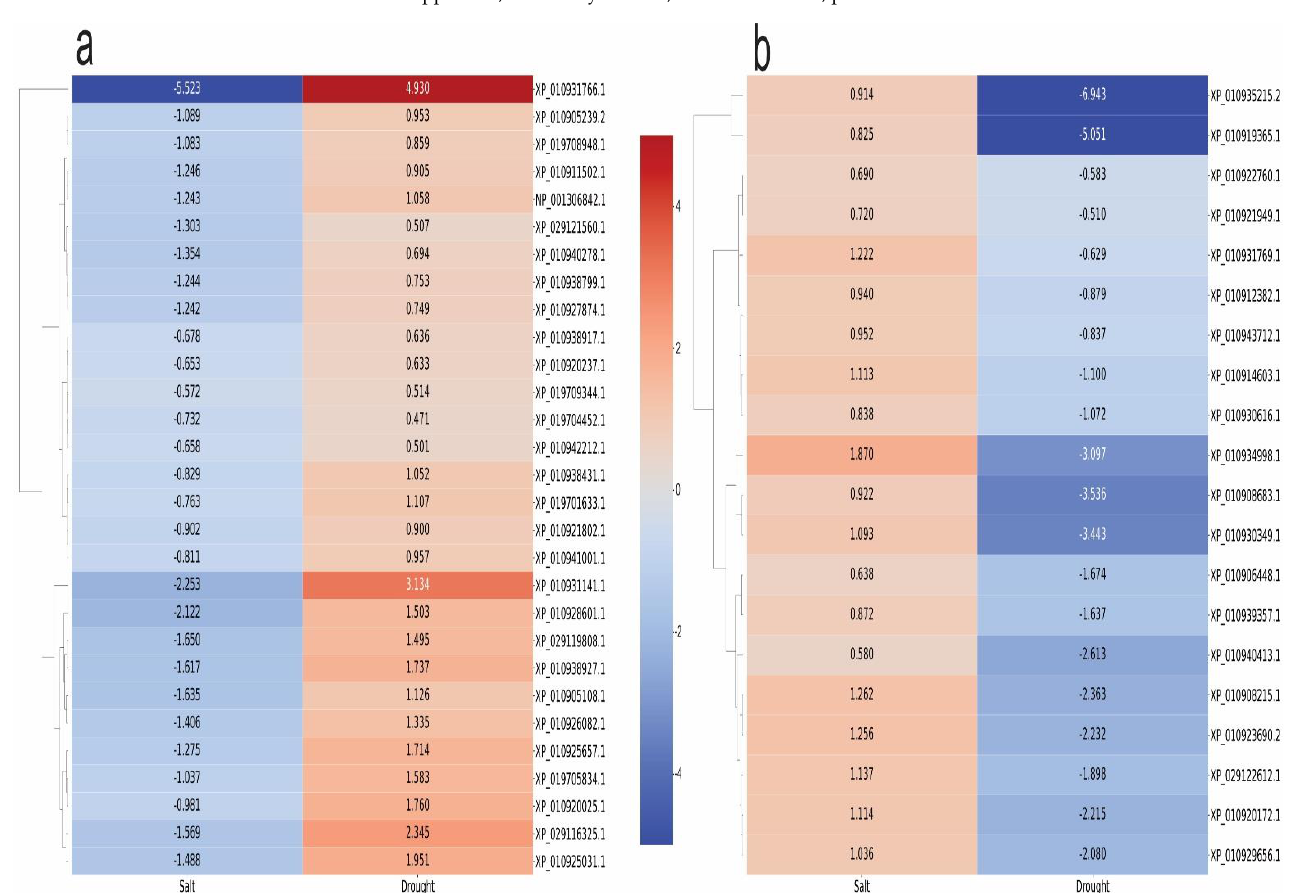
Figure 6. Heatmap of the differentially expressed enzymes from transcriptomics analysis that showed different qualitative profiles in the two scenarios studied — drought and salinity stresses. ( a ) — downregulated in salt and upregulated in drought stress; and ( b ) — upregulated in salt and downregulated in drought stress.